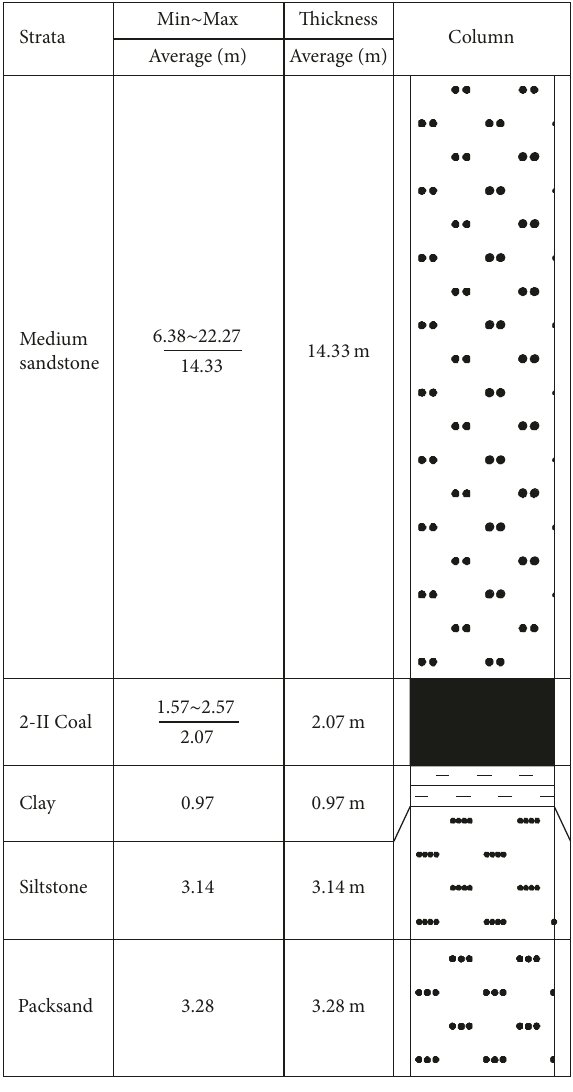
Figure 2: Combined geological column of coal